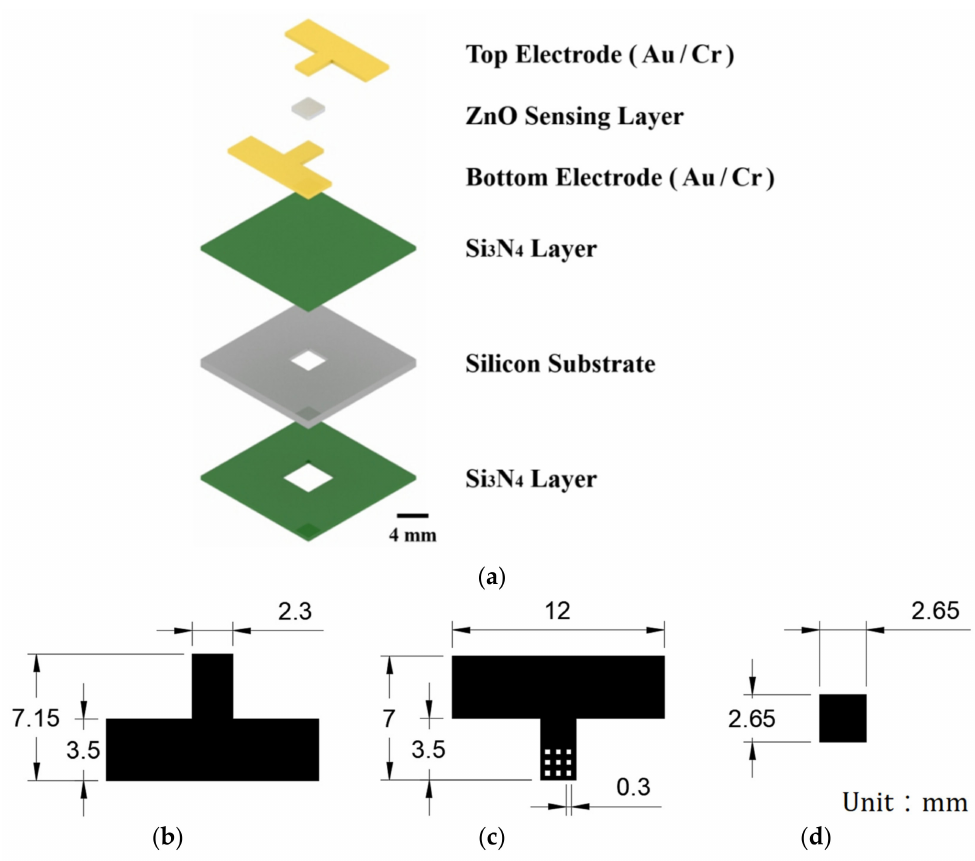
Figure 2. Designs of MEMS-based pyroelectric infrared sensors: ( a ) structural arrangement of sensor, and dimensions of ( b ) bottom electrode, ( c ) top electrode and ( d ) sensing